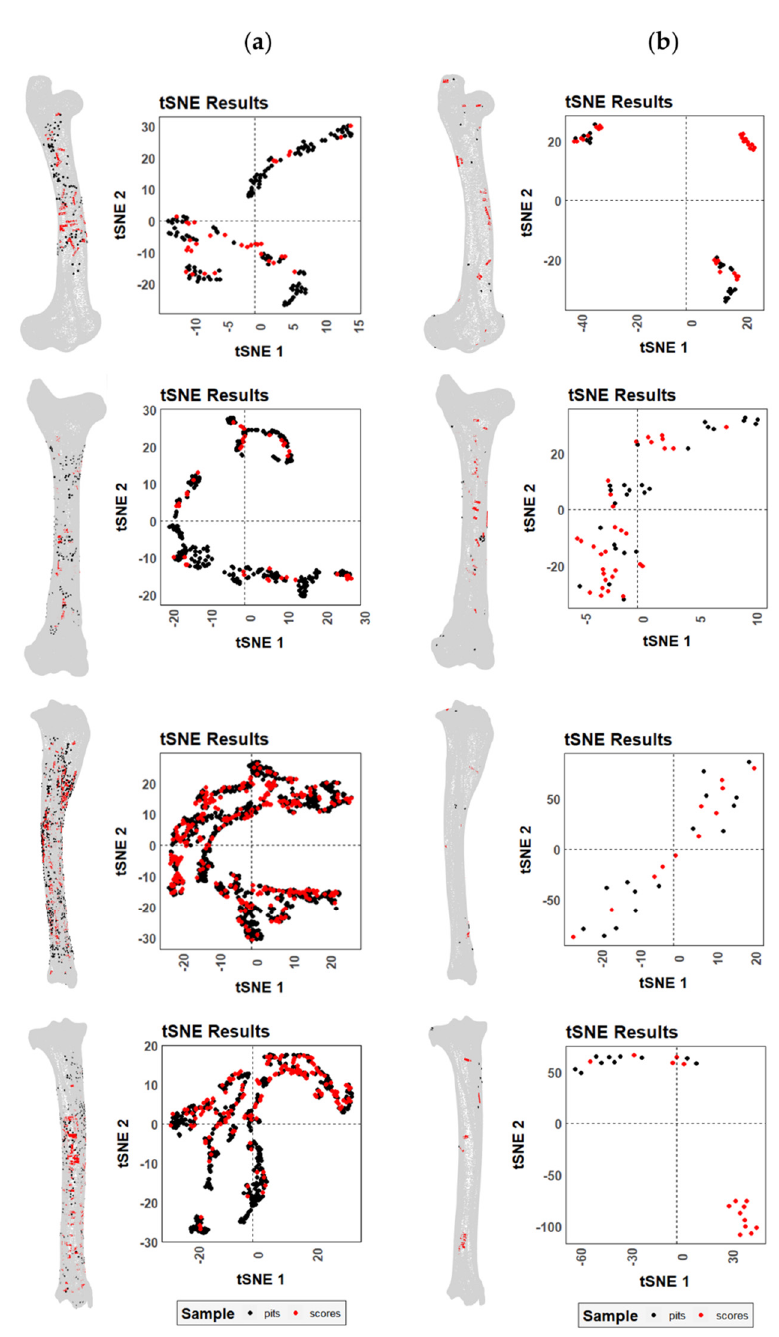
Figure 6. t-SNE scatter plots for both tooth scores and pits on the right and left femora and tibiae modified by ( a ) captive and ( b ) wild wolves.